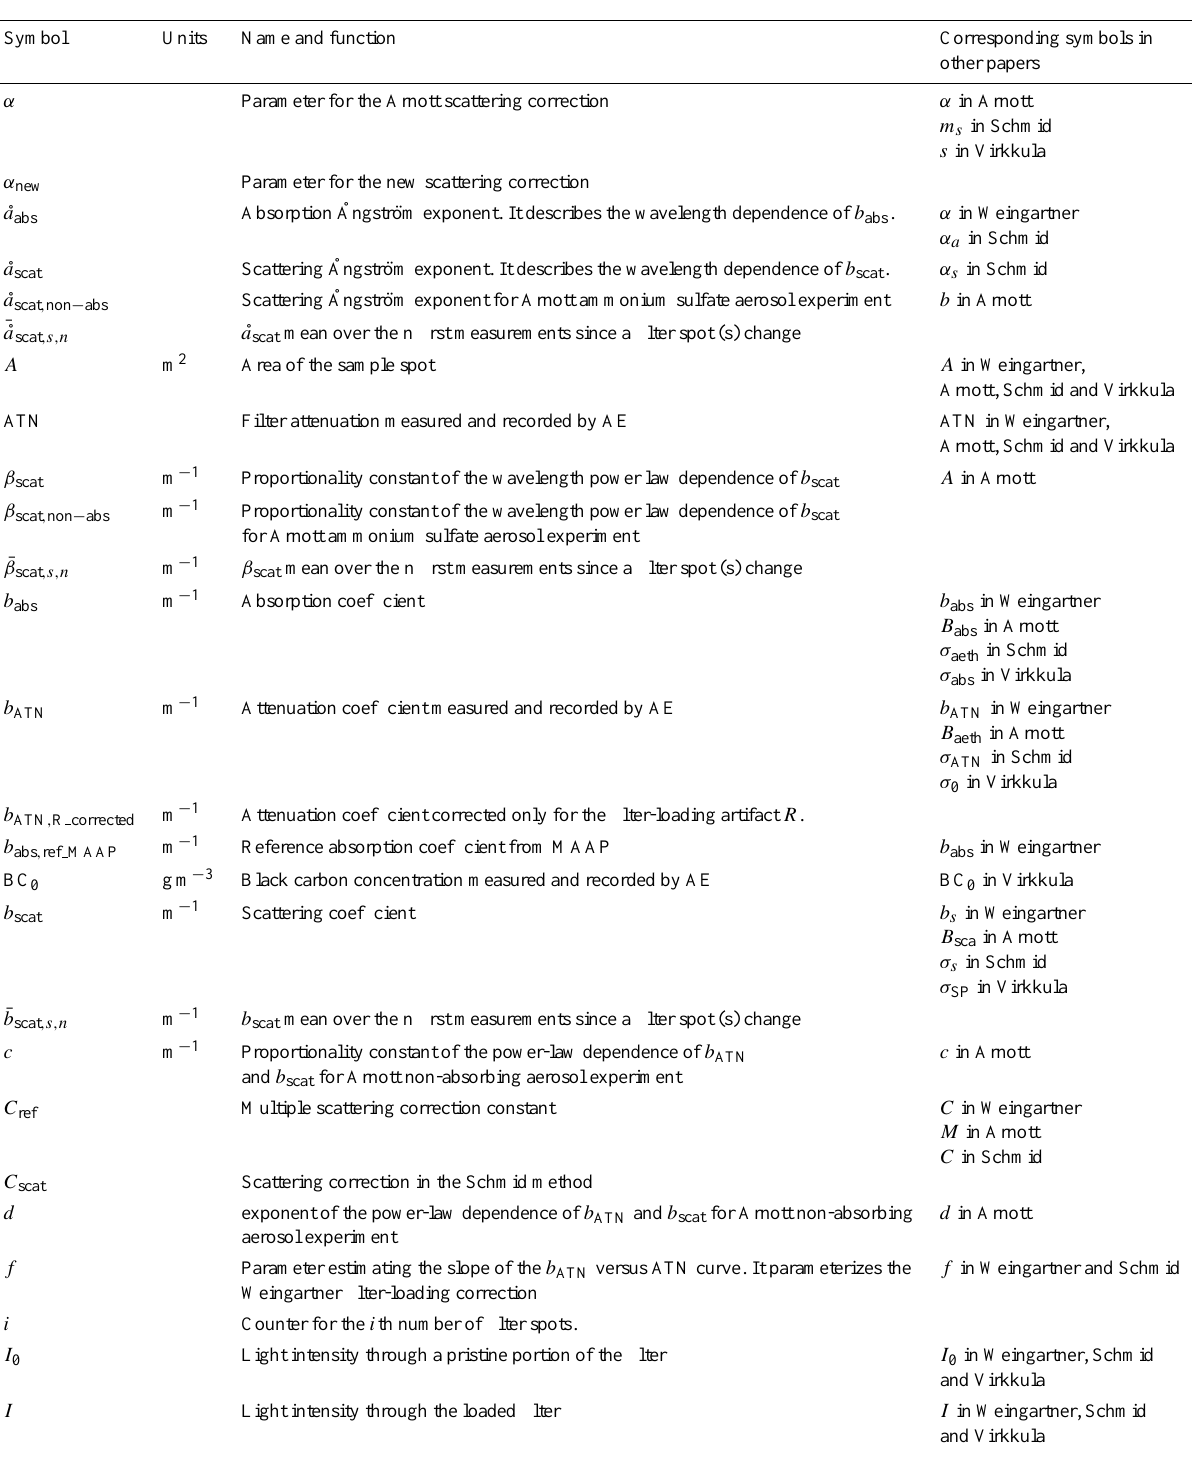
Table 2. Symbols, units, description of the parameters used in this paper as well as the corresponding symbols used in the papers describing the previously published correction schemes. The used nomenclature follows symbols commonly used by Seinfeld and Pandis (1998).